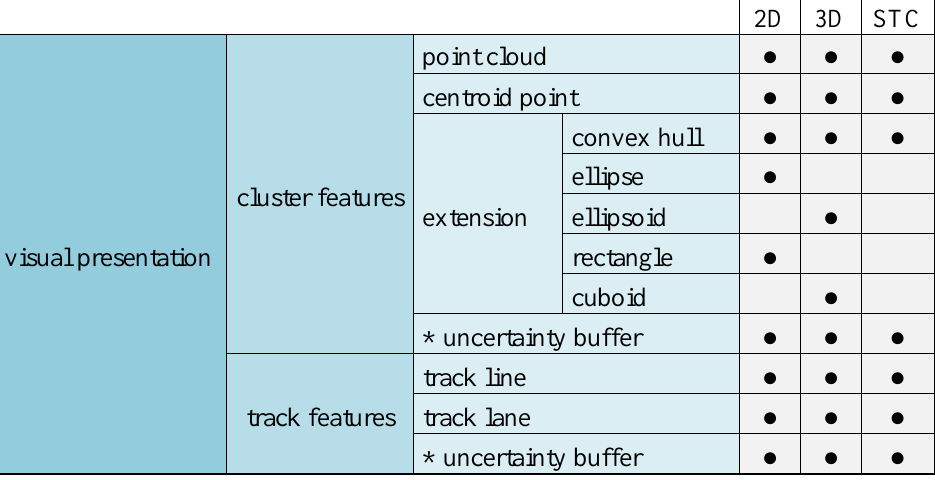
Table 2. Visual presentation of past and predicted lightning